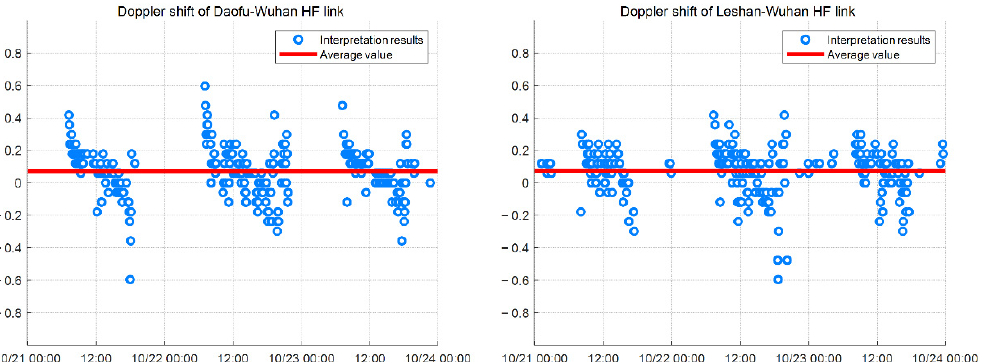
Figure 8. The relationship between the Doppler shift of the two HF links with time. The left panel represents the Daofu–Wuhan link, and the right panel represents the Leshan–Wuhan link. The blue circles represent the results of the Doppler shift interpretation, and the red lines represents the average value of the Doppler shift. The average Doppler shifts of the Leshan–Wuhan link and the Daofu–Wuhan link are 0.0733 Hz and 0.0714 Hz.